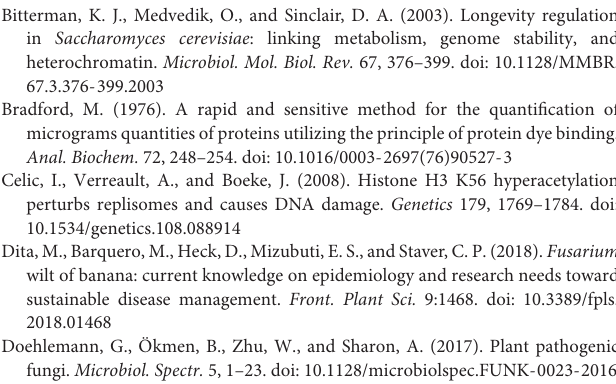
FIGURE S1 | The differential effect of NA on conidial germination and mycelium growth does not stem from the type of media used. (A) Agar plugs covered with mycelia of F. oxysporum were incubated in PDB or PDB containing 10 mM NA for 5 days shaking at 28 ◦ C. Next, the mycelia were collected and put on a clean petri dish. The petri dish was scanned and the surface of the mycelia was calculated using ImageJ software. The surface size of the treated mycelium was 77% of the untreated one. (B) 5000–1000 conidia were spotted on PDA plates with 0, 5, and 10 mM NA. The plates were incubated for 5 days at 28 ◦ C and scanned. TABLE S1 | RNA sequencing results of F. oxysporum exposed to NA conidia were grown in PDB for 5 h followed by 3 h of NA exposure. RNA purification, sequencing, and analysis are described in “Materials and Methods.” Raw and adjusted reads for each gene of four biological repeats, with or without NA exposure, are presented, including fold-increase and significance of the increase. TABLE S2 | List of upregulated and downregulated genes in F. oxysporum following NA exposure. Only genes that are either upregulated or downregulated by twofold or more are described. p -value threshold for significance was set to be 0.05. TABLE S3 | List of upregulated genes used for STRING analysis. Details in the